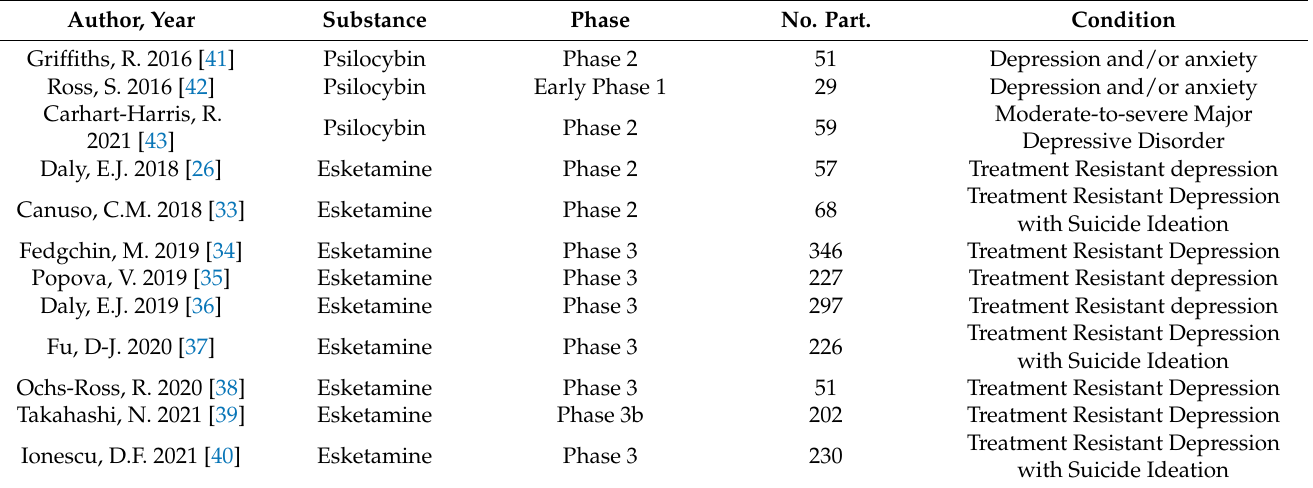
Table 1. Recent randomized, placebo-controlled studies concerning psilocybin and esketamine in depres- sion.